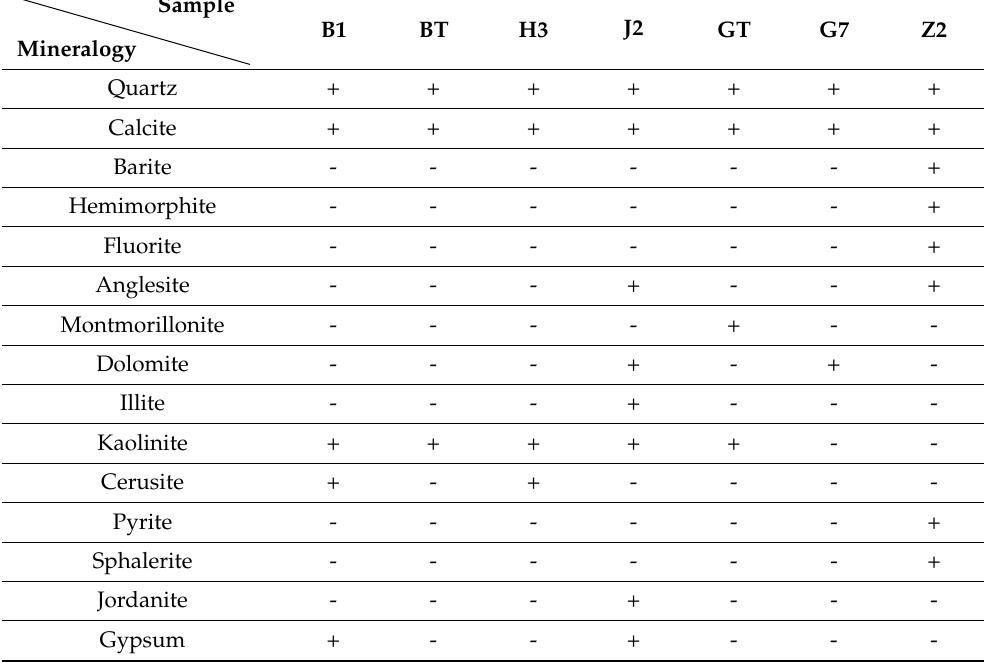
Table 4. Mineralogical composition of soil samples.